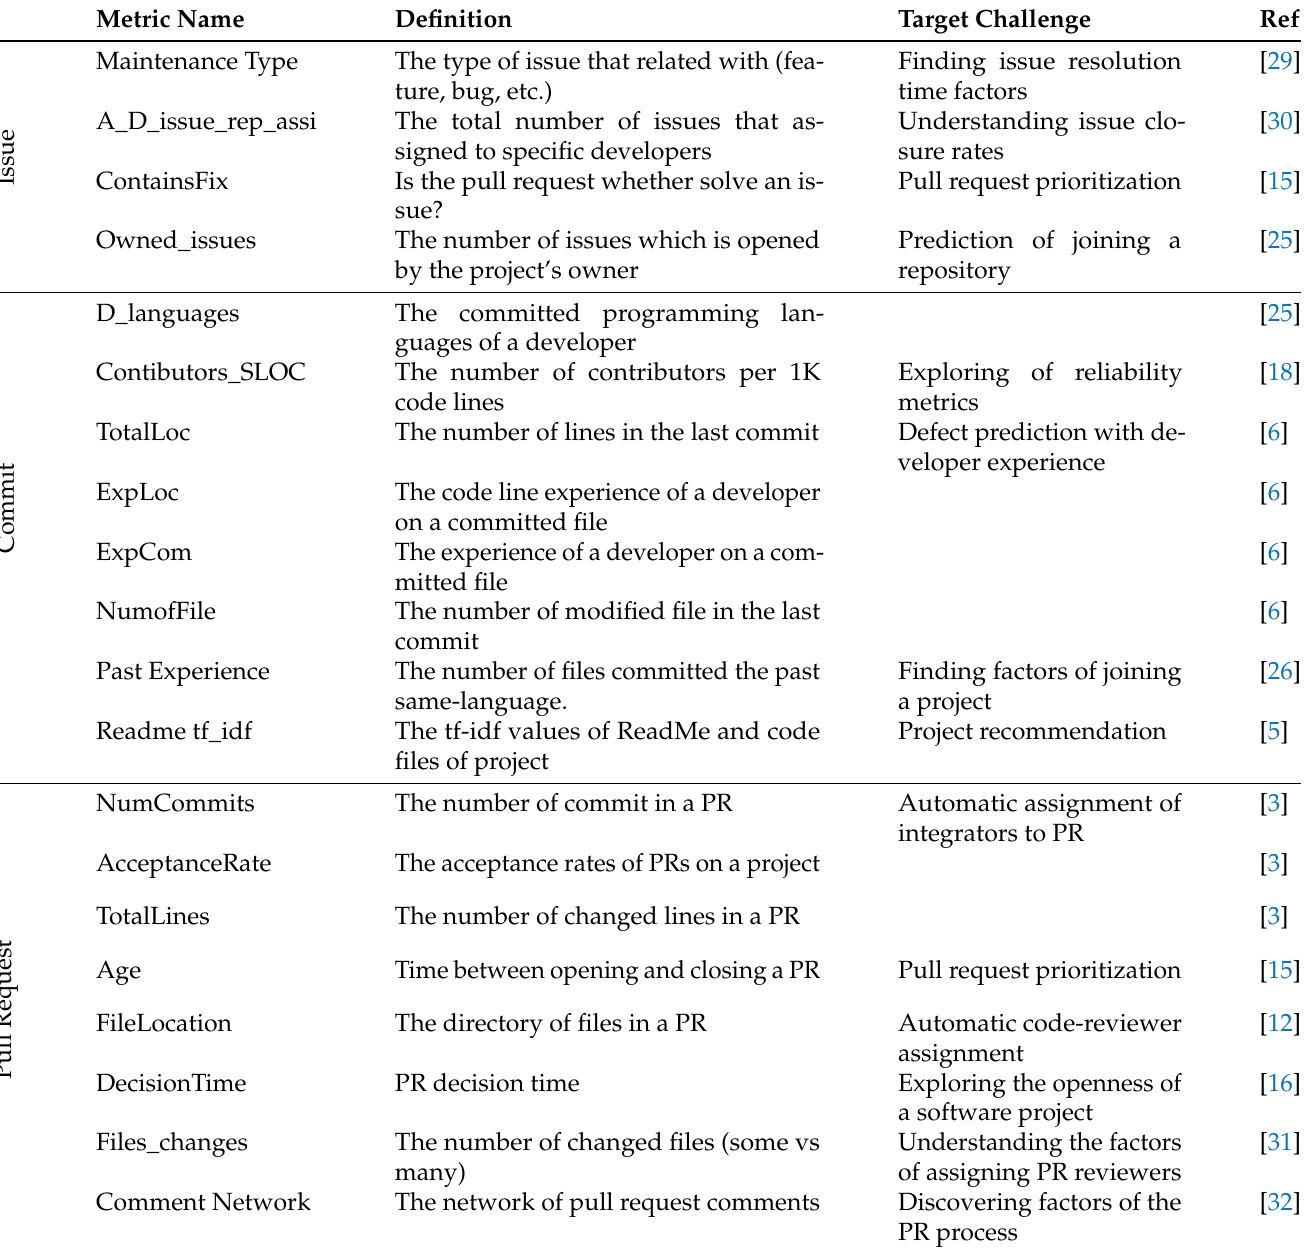
Table 1. Used metrics samples in the literature with GitHub